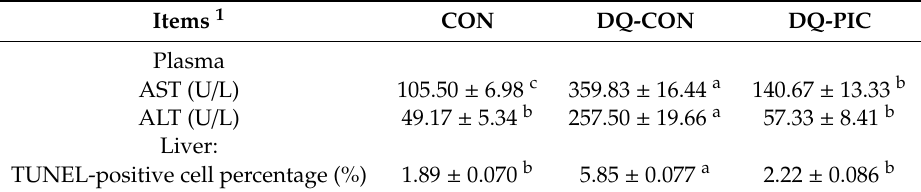
Table 4. E ff ects of piceatannol supplementation on the contents of plasma AST and ALT and hepatic apoptosis rate in diquat-induced